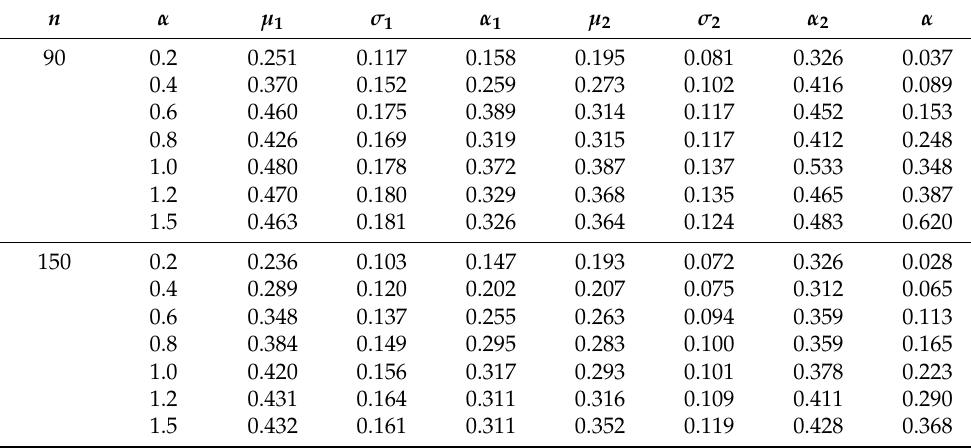
Table 2. Parameter estimates; empirical standard deviation.